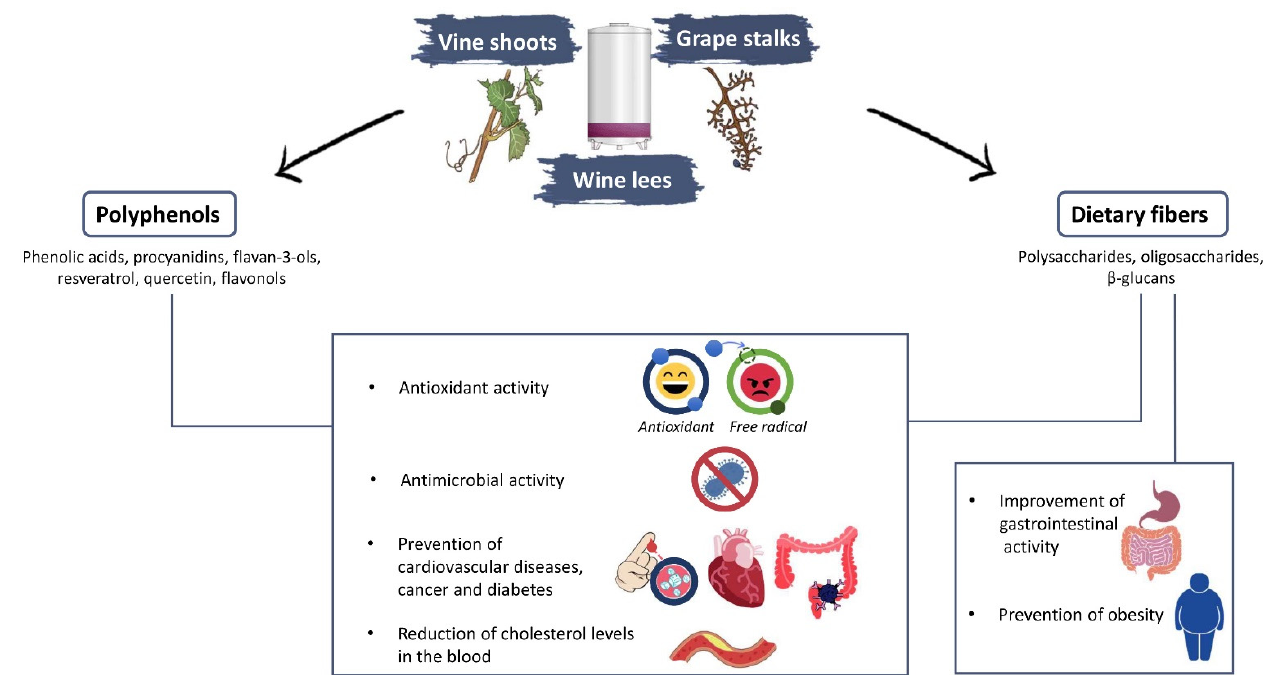
Figure 1. Effects of phenolic compounds and dietary fiber on health.